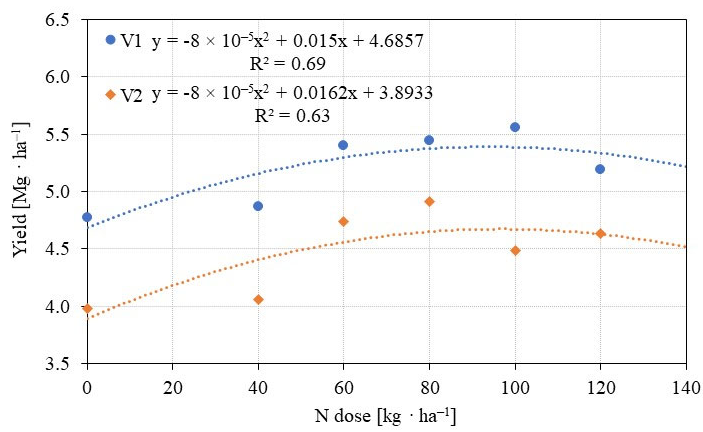
Figure 4. Grain yield of winter wheat genotypes depending on nitrogen fertilization.